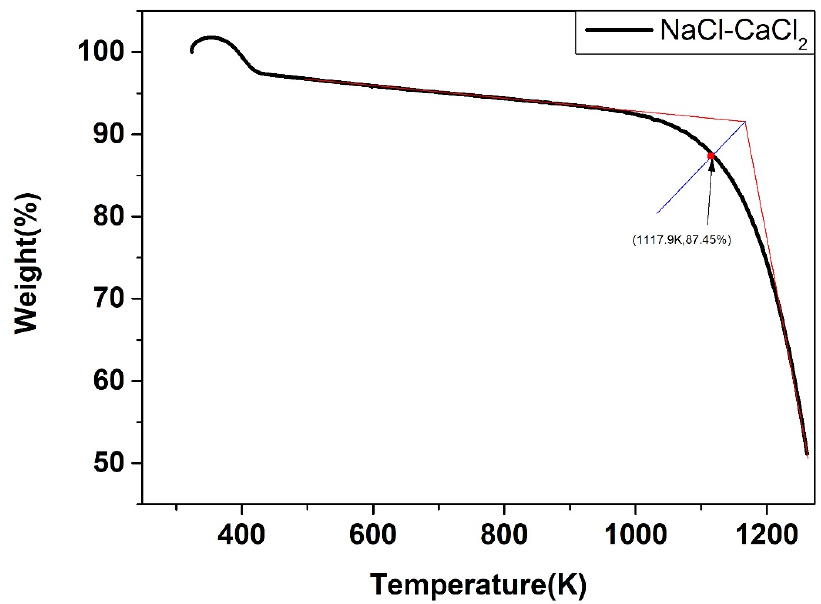
Figure 23. Weight change (wt.%) of the NaCl-CaCl 2 binary chloride salt.